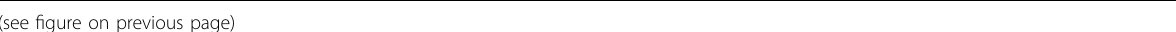
Fig. 4 Evaluating p53 role in context of β -catenin osteogenic activity in MPCs. Mutant and control MPCs in this fi gure are same as in Fig. 3. A β -Catenin – p53 – MPCs displayed higher alkaline phosphatase activity than that of β -catenin – MPCs. B Ad-Cre transduced MPCs were induced for osteogenic differentiation in vitro and assayed for mineralization by Von Kossa (black box) and for adipocytes by Oil Red (red box). Cells were imaged live using EVOS microscope. White arrows: adipocytes; yellow arrows: mineralized nodules. ICC with anti-Col1 and anti-Ocn antibodies validated ossi fi cation of β -catenin – p53 – MPCs. C p53 – MPCs were treated with either DMSO (vehicle) or 5 µM XAV939 and induced for osteoblastic differentiation. It only took as few as 4 days for the XAV939-treated p53 – MPCs to mineralize, shown by Von Kossa. D The μ CT images of humeri from 6-week-old X/CKO and X/DKO mice, metaphyseal trabeculae excluding cortices shown in pseudo-red. E MPCs isolated from the p53 R245W/ + ;Ctnnb1 fl / fl ; ROSA26R-Tomato and p53 R245W/R245W ;Ctnnb1 fl / fl ;ROSA26R-Tomato mice were transduced by Ad-Cre. The β -catenin – p53 R245W/R245W tm MPCs formed mineralized nodules 4 days after osteo-induction. Yellow arrow indicates mineralized bone